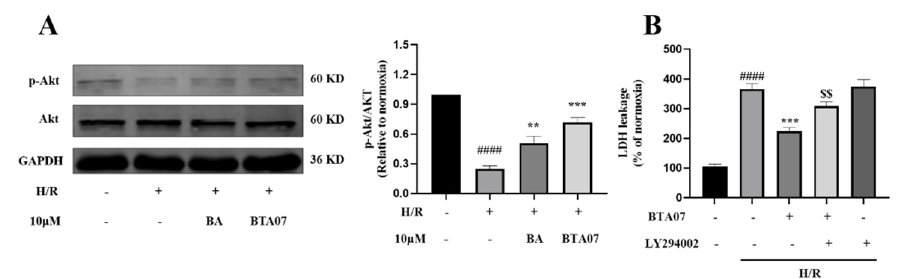
Figure 6. BTA07 recovered PI3K/Akt signaling suppressed by H/Rin ARCMs. ( A ) Left panel: a representative image; right panel: average data. ( B ) ARCM damage was determined by LDH release following treatment with 10 µ M of LY294002. Data are presented as means ± S.E.M for three independent experiments. #### p < 0.0001 vs. normoxia group; *** p < 0.001 vs. vehicle group; ** p < 0.01 vs. vehicle group; $$ p < 0.01 vs. BA group; one–way ANOVA test, followed by a Student–Newman–Keuls test.